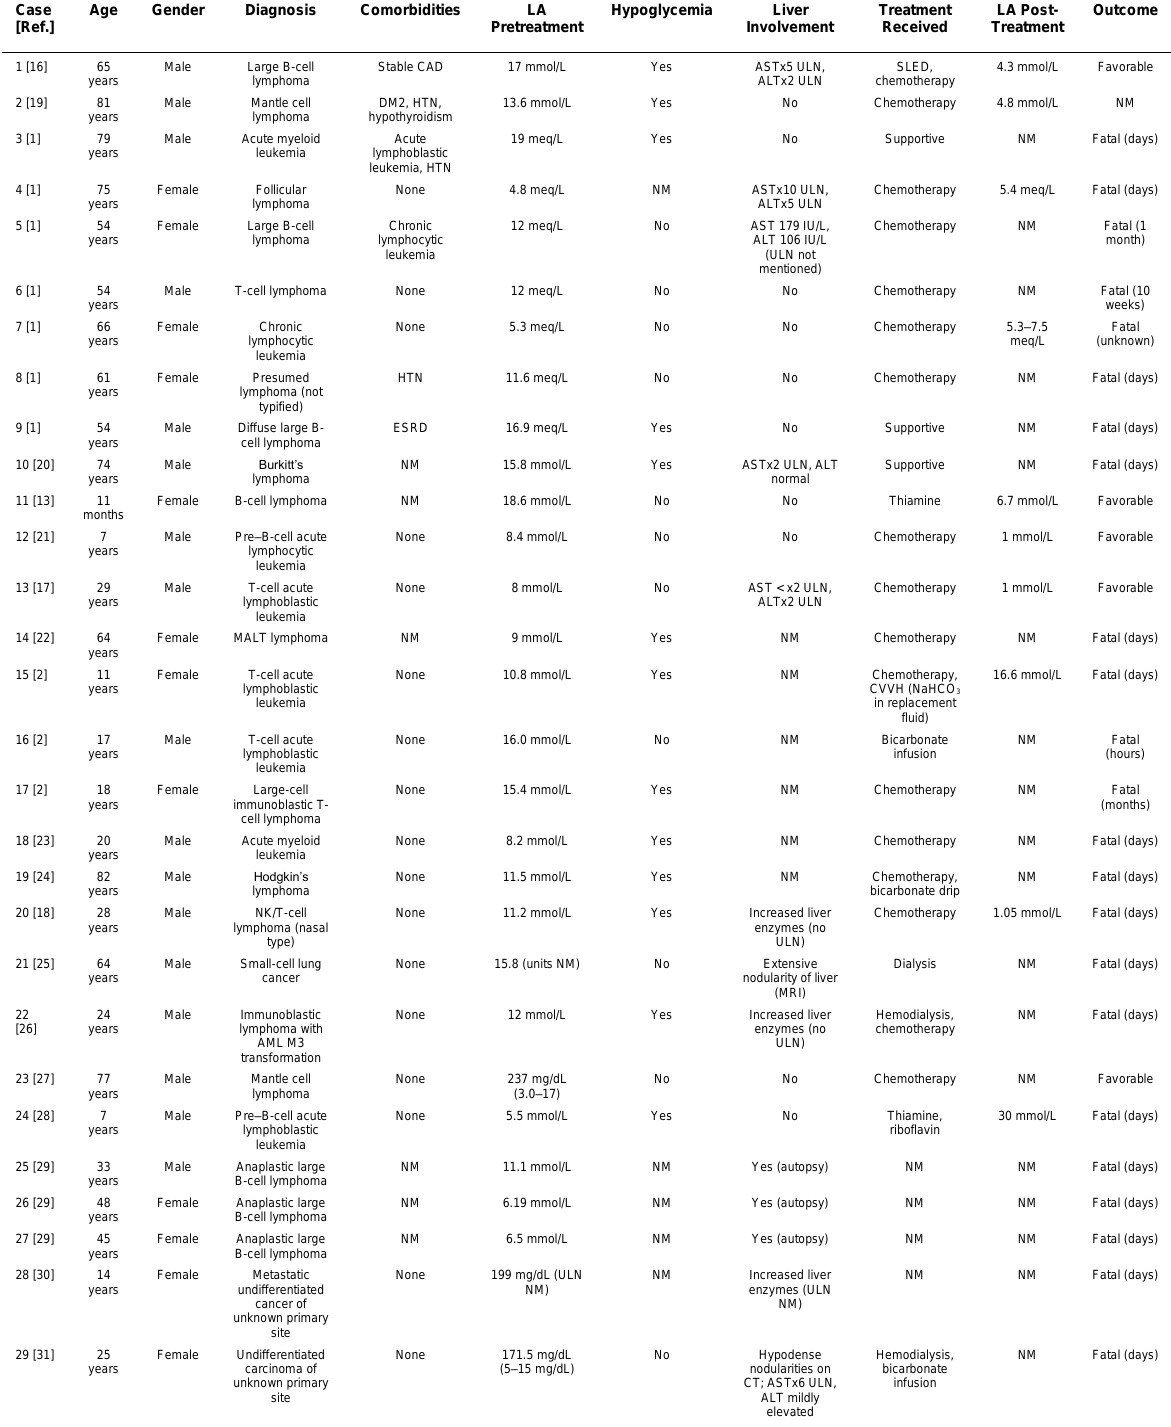
Case Reports of Type B Lactic Acidosis Secondary to Malignancies in the Past 10 Years (2000 – 2010) and Their Response to Treatment Case